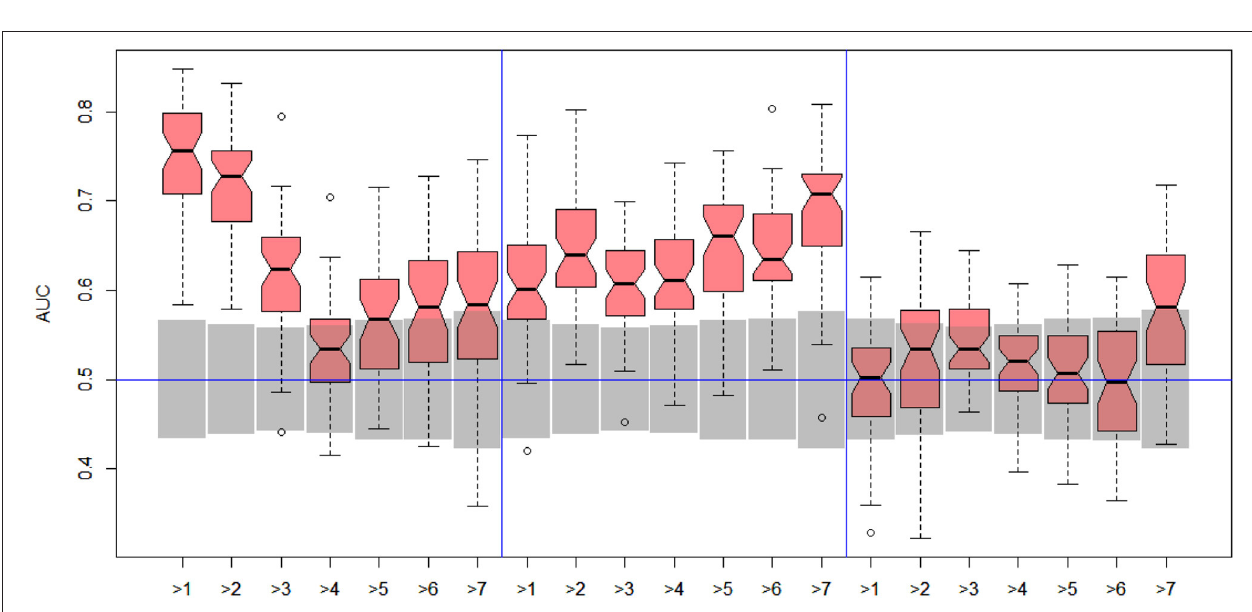
FIGURE 5 | DILI2 scanning results for MOLD (left) , FAERS (middle) , and tox21 (right) data sets. Gray boxes correspond to 95% confidence interval for the null